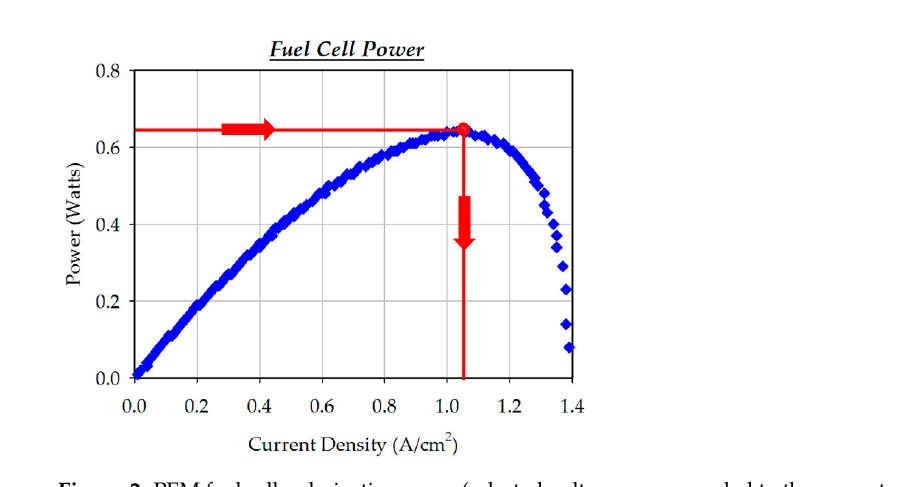
Figure 2. PEM fuel cell polarization curve (selected voltage corresponded to the current at peak power).